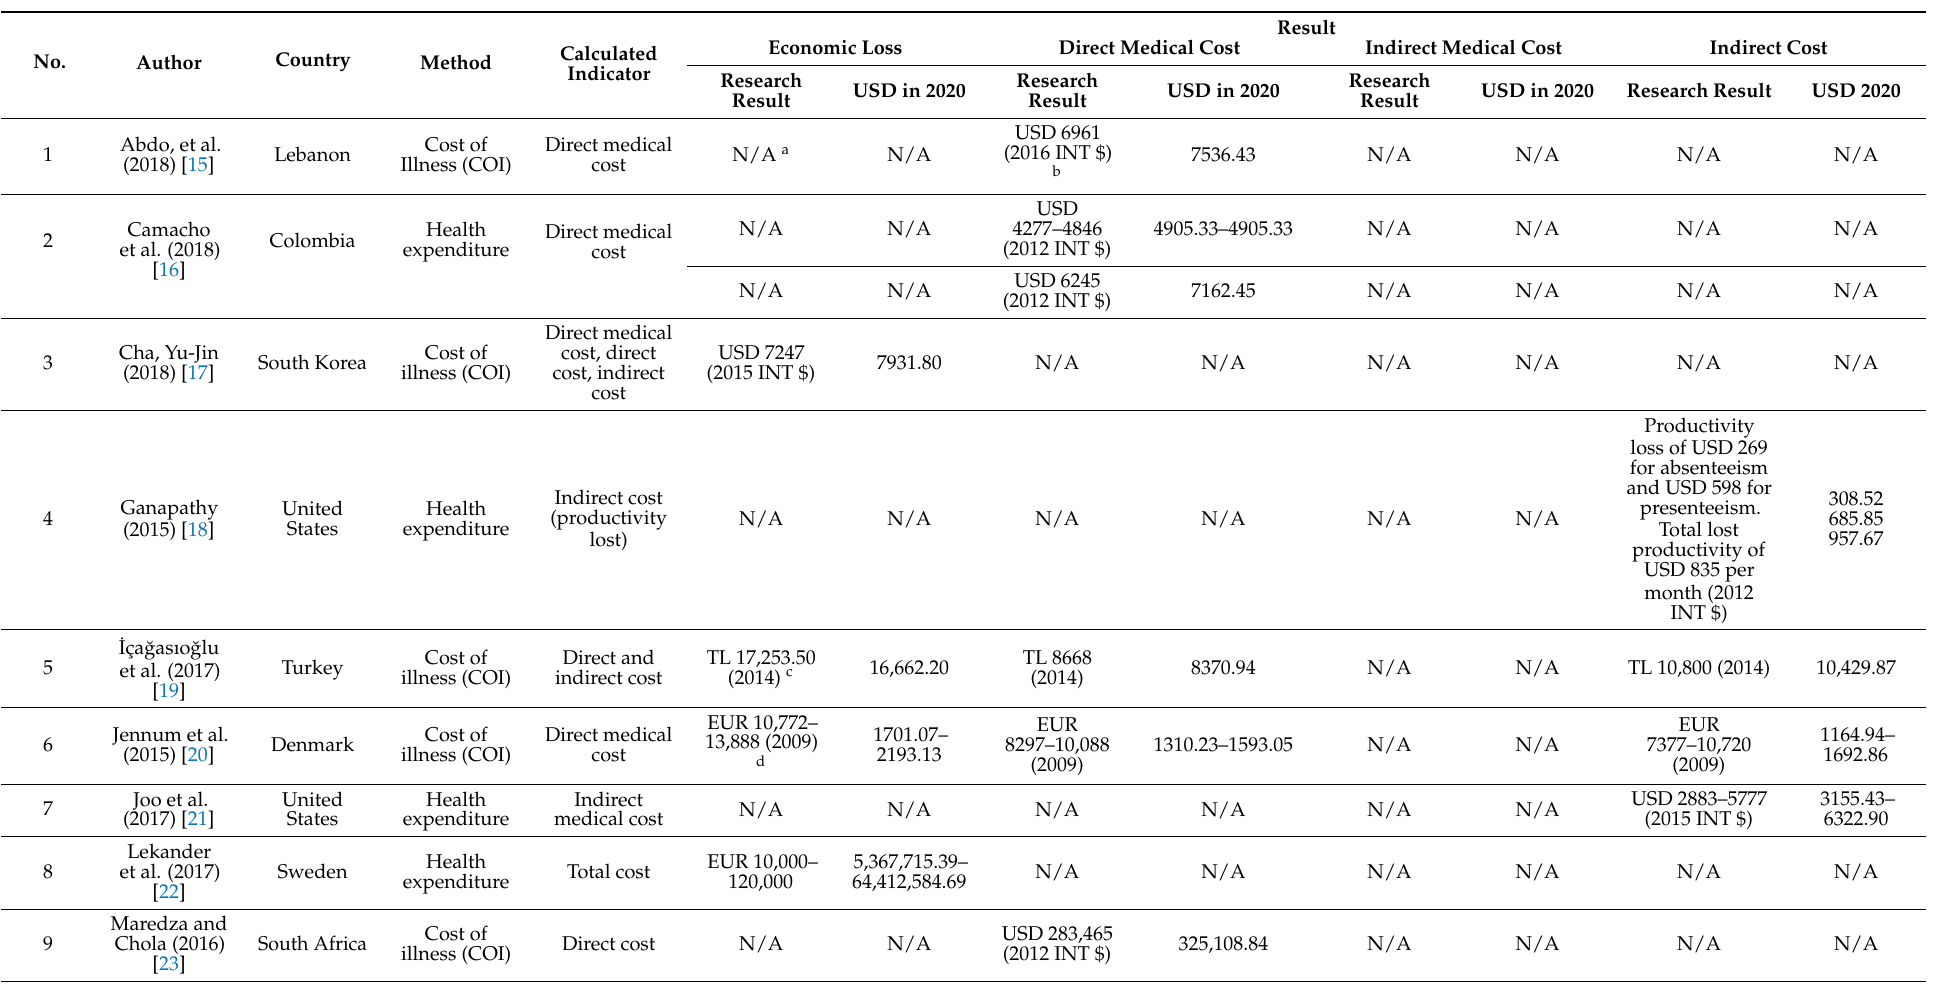
Table 3. Results of cost conversion due to